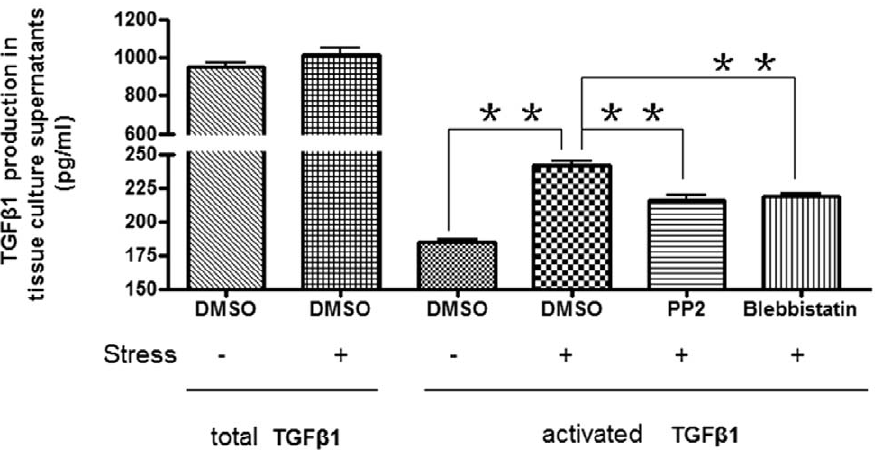
Figure 2. Strain induces the activation of latent TGF b in human gingival fibroblasts. As described in Methods, equal numbers of HGF were seeded into plates containing collagen type I-coated membranes, and were treated with or without mechanical strain for 24 hours. As described in methods, ELISA was used to detect total and activated TGF b in the presence or absence of DMSO, blebbistatin (which blocks activation of TGF b by impairing actin/myosin-dependent cell contraction [24,29,30]) or the FAK/src inhibitor PP2. Note induction of active TGF b at the 24 hour time-point in the presence of strain and DMSO relative to cells treated with blebbistatin, strain and PP2, and control cells not subjected to strain. Data shown are the average value from three independent individuals (3 replicates per experiment ) 6 SE. **=p , 0.01.